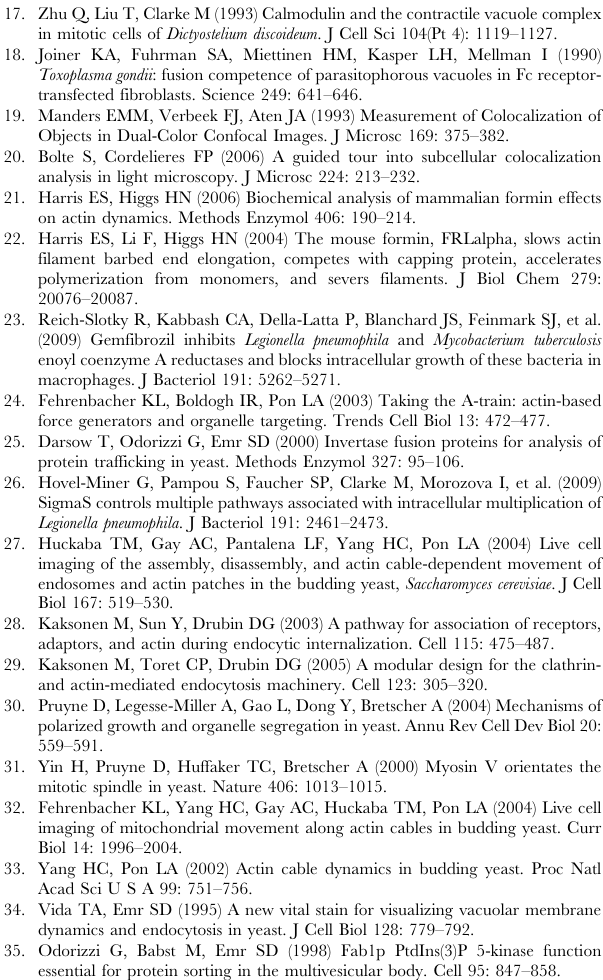
Figure S2 Localization of VipA-GFP and VipA-1-GFP in transiently transfected CHO-Fc c RII cells. CHO-Fc c RII cells were transfected with plasmids expressing EGFP (pEGFP-